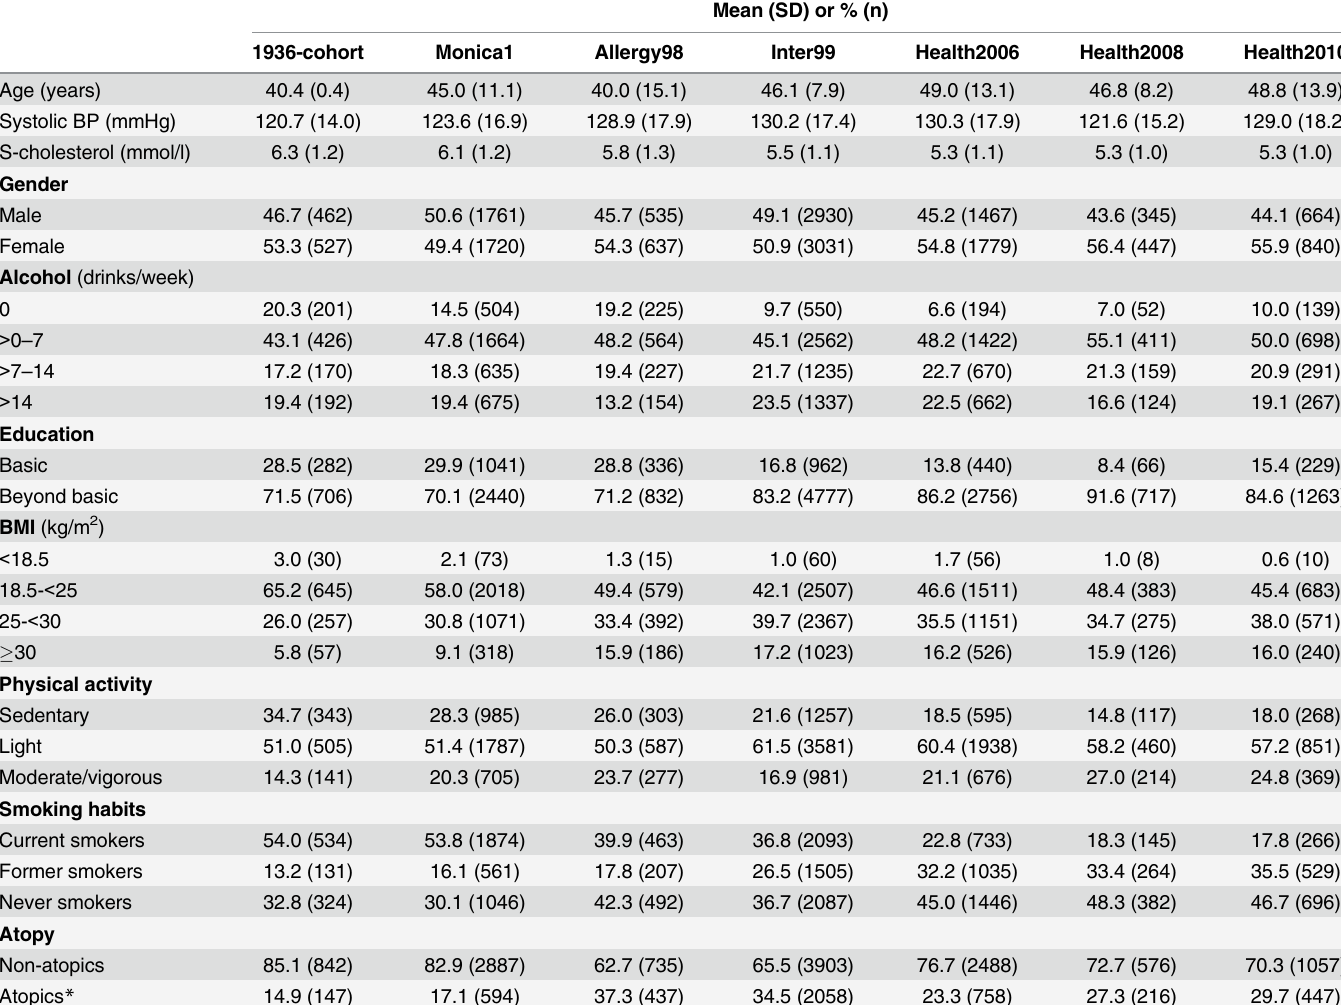
Table 1. Characteristics of the study